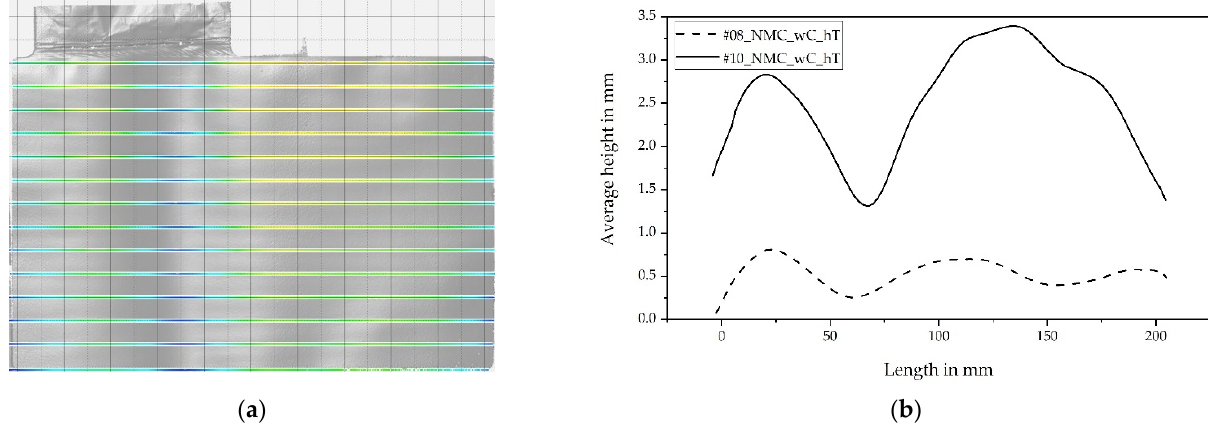
Figure 15. ( a ) Exemplary single electrode sheet, with contour lines across the width of the electrode in the running direction; ( b ) summarized contour lines from experiments No. 8 and No. 10 .